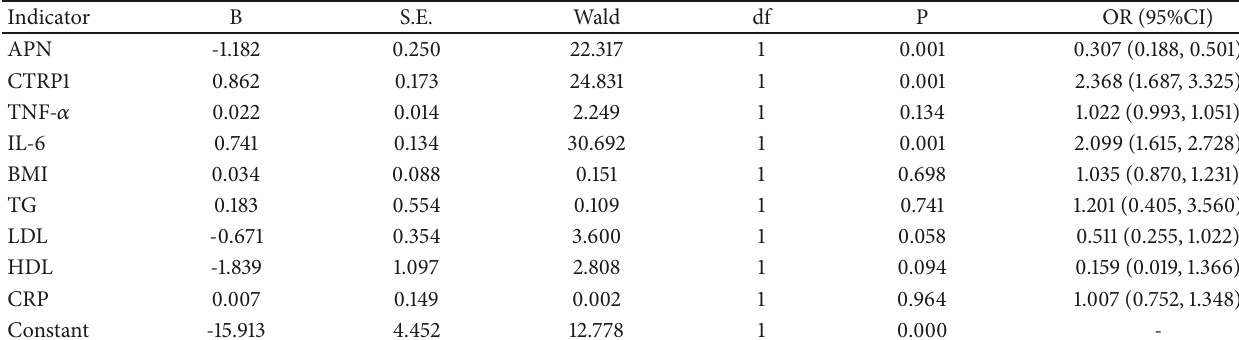
Table 4: Multiple logistic regression analysis of factors influencing STOD in hypertension.